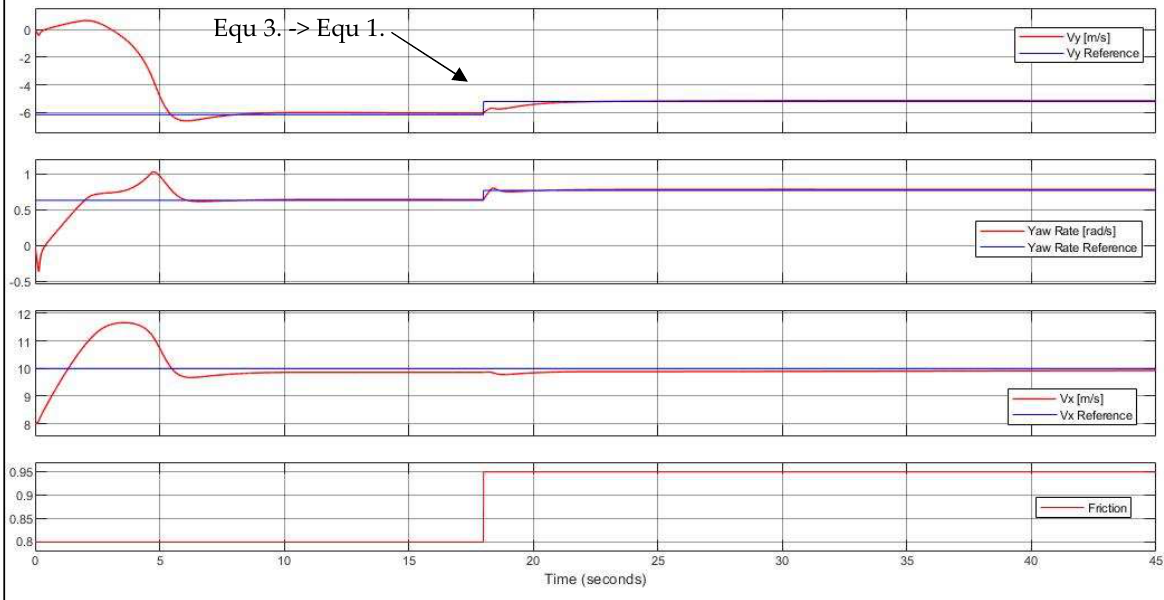
Figure 11. Vehicle states during the test case showing the handling of rapid change of road surface grip.